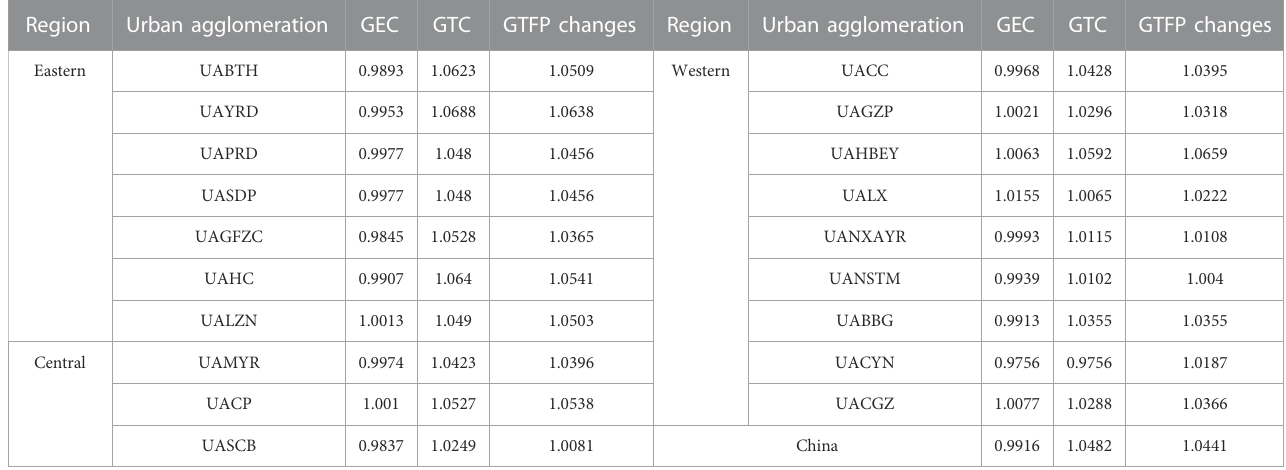
TABLE 1 Average values of region GTFP and decomposition changes of Chinese urban agglomerations from 2010 to 2019.